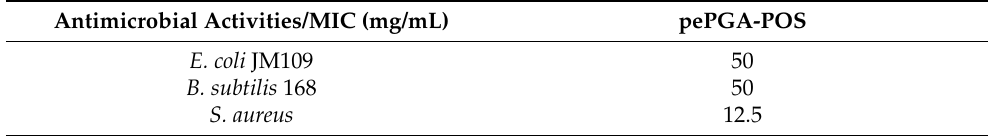
Table 1. The minimum inhibitory concentration (MIC) of pePGA-POS to inhibit the growth of E. coli JM109, B. subtilis 168 and S.